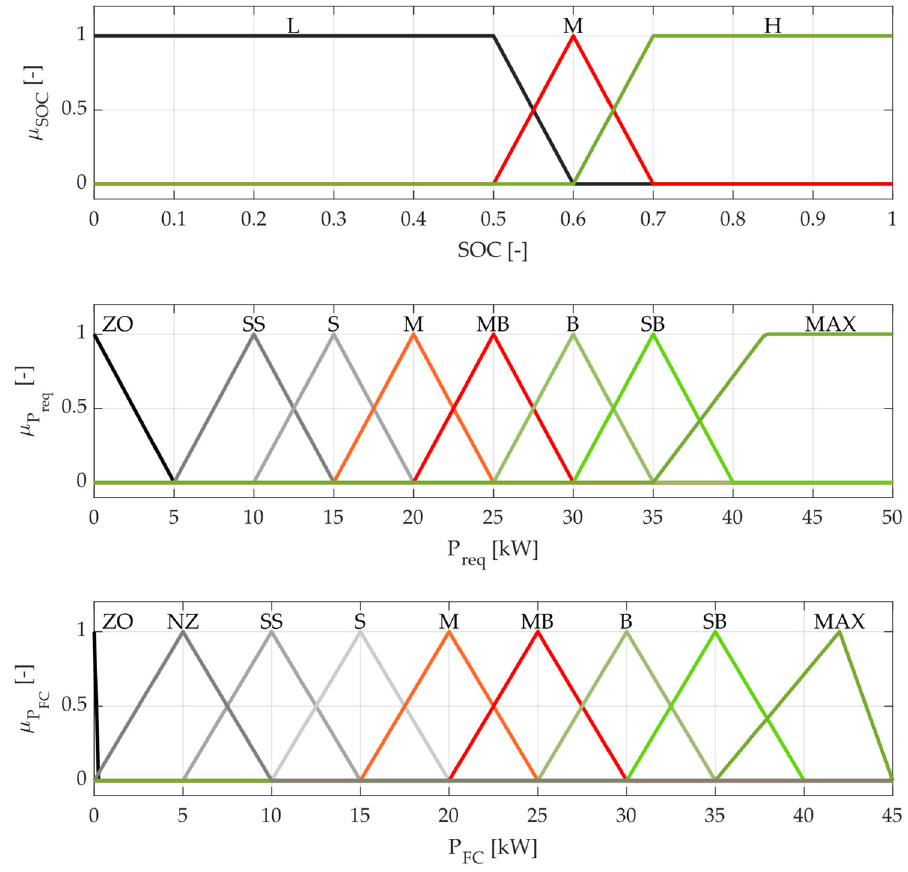
Figure 7. Membership function of fuzzy logic inputs ( P req , requested power and SOC, battery state of charge) and output ( P FC , power to be provided by the fuel cell system).